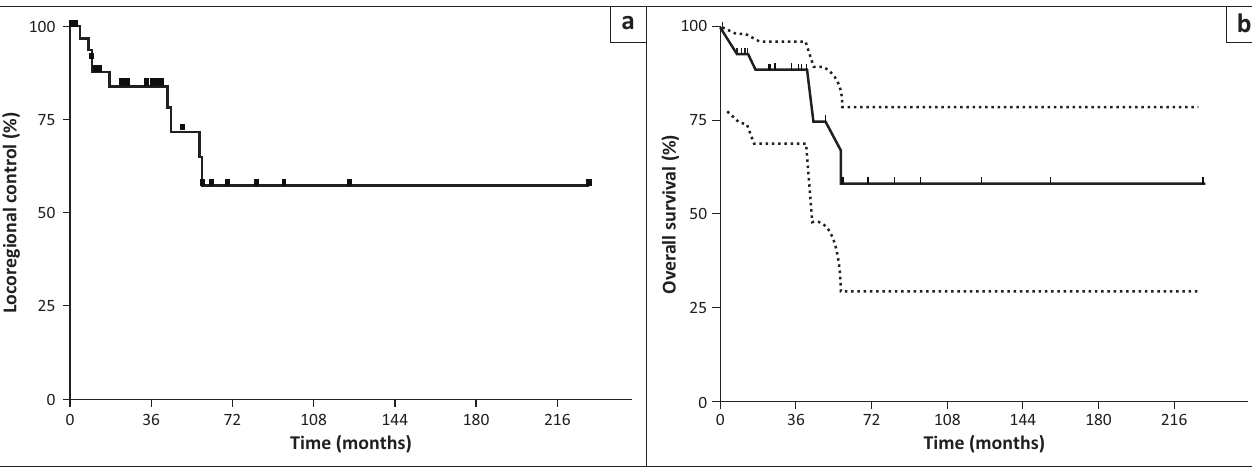
FIGURE 1: Kaplan-Meier survival curves for total population: LRC and OS (includes error bars which indicates small patient numbers leading to a large difference between results) in non-metastatic